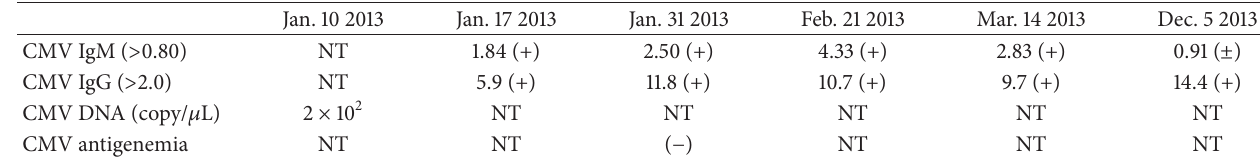
Figure 2: Ventilation and perfusion scan showing multiple areas of mismatch in bilateral lungs on admission (a) and resolved areas of mismatch after anticoagulant therapy (b). Table 2: Results of serological, PCR, and antigenemia testing for CMV